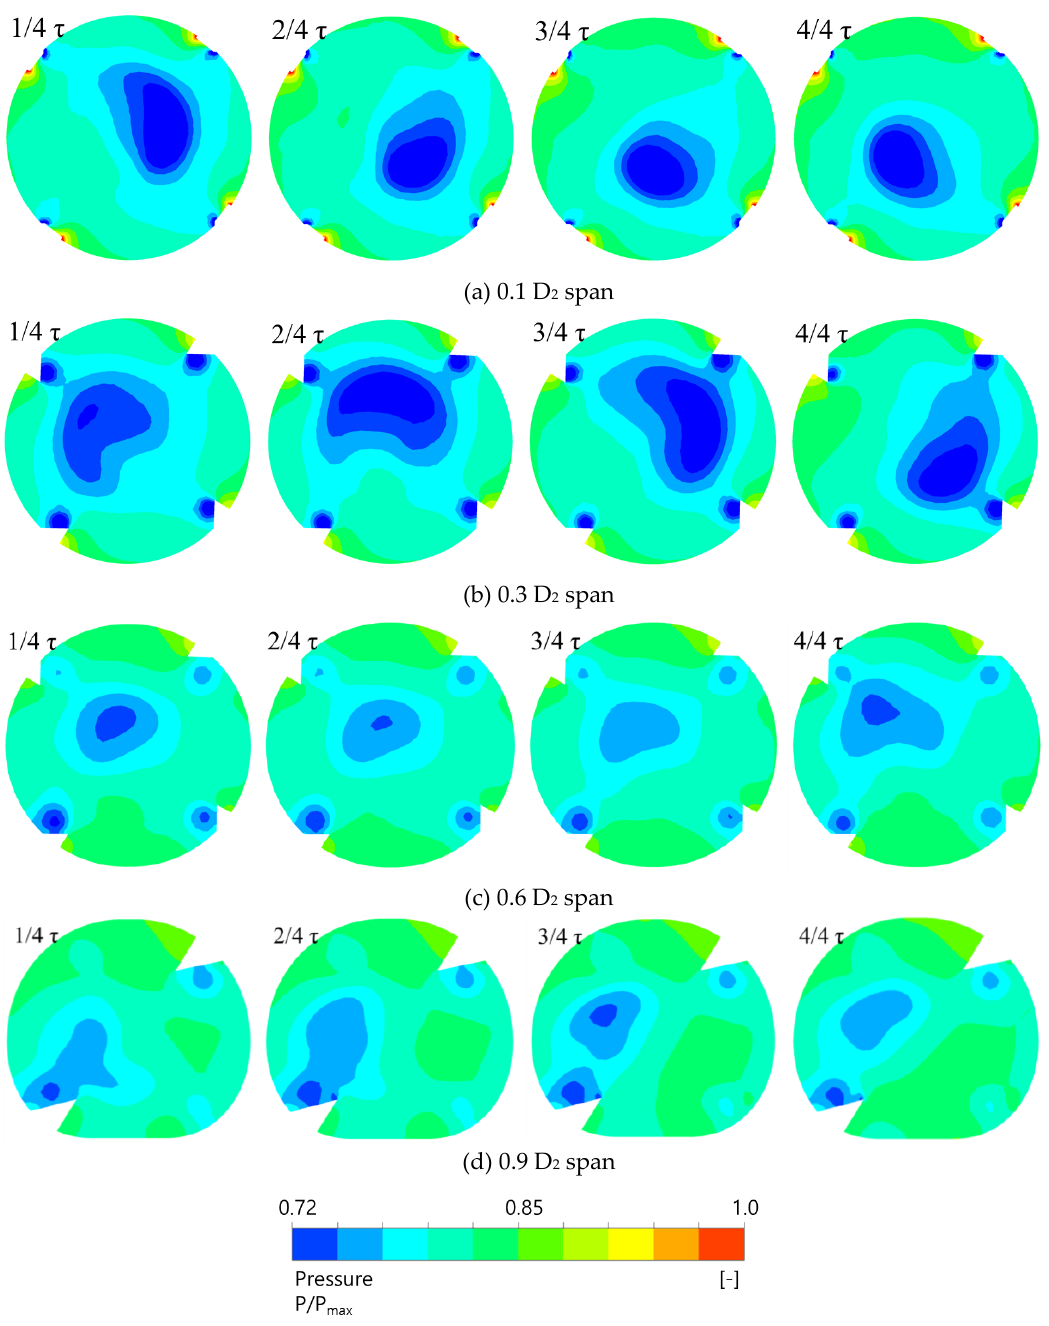
Figure 14. Pressure distributions on observed spans in the DT with anti-cavity fins at the GV at 16° during one revolution of the runner: span locations at (a) 0.1, (b) 0.3, (c) 0.6, and (d) 0.9 D 2 .